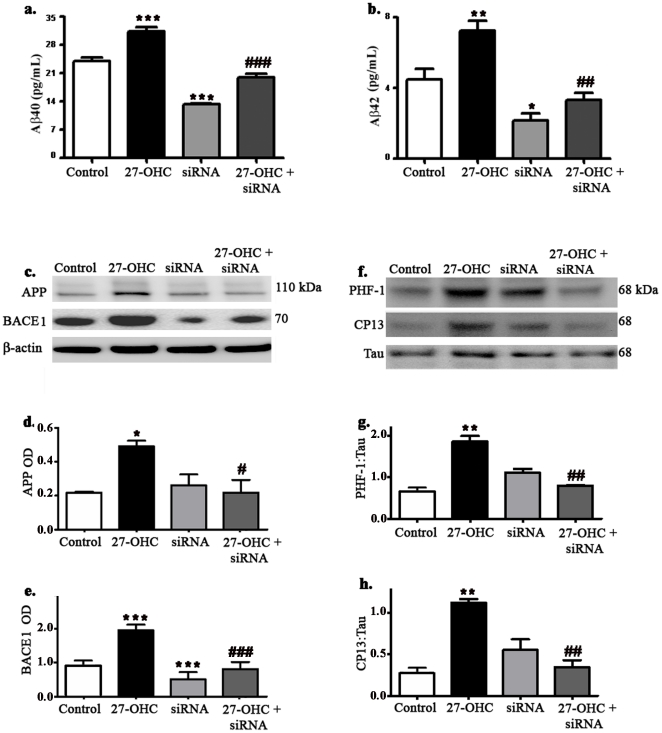
siRNA to gadd153 reduces 27-OHC-induced increase in Aβ production and tau phosphorylation.27-OHC significantly increased levels of both secreted Aβ40 and Aβ42, and treatment with siRNA, alone or in presence of 27-OHC, significantly reduced Aβ40 and Aβ42 levels (a,b). siRNA to gadd153 also reduced 27-OHC-induced increase in APP and BACE1 levels (c–e). Note that siRNA to gadd153 markedly reduced basal levels of BACE1, suggesting that gadd153 regulates BACE1 transcription (c,e). Treatment with 27-OHC also increases phosphorylation of tau as detected with PHF-1 and CP13 antibodies (f–h). The increase in phosphorylated tau is reduced by treatment with siRNA to gadd153. *p<0.05, **p<0.01 and ***p<0.001 versus controls; #p<0.05, ##p<0.01 and ###p<0.001 versus 27-OHC.